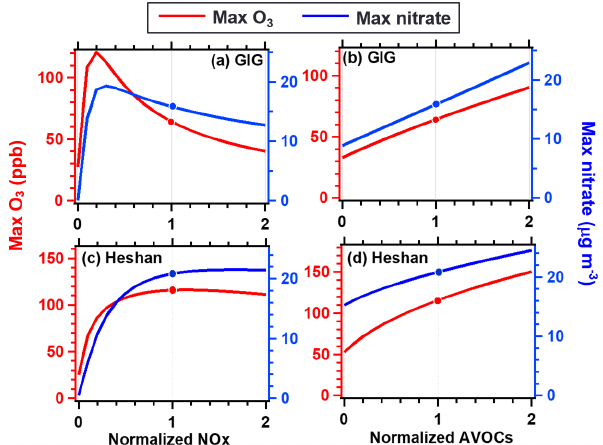
Figure 11. Simulated maximum ozone and nitrate concentration with normalized NO x and AVOCs at the (a, b) GIG site and (c, d) Heshan site, cutting through the simulated isopleth in Figure 8 with normalized AVOCs and NO x ratio at 1, respectively. The red and blue circles represent the base